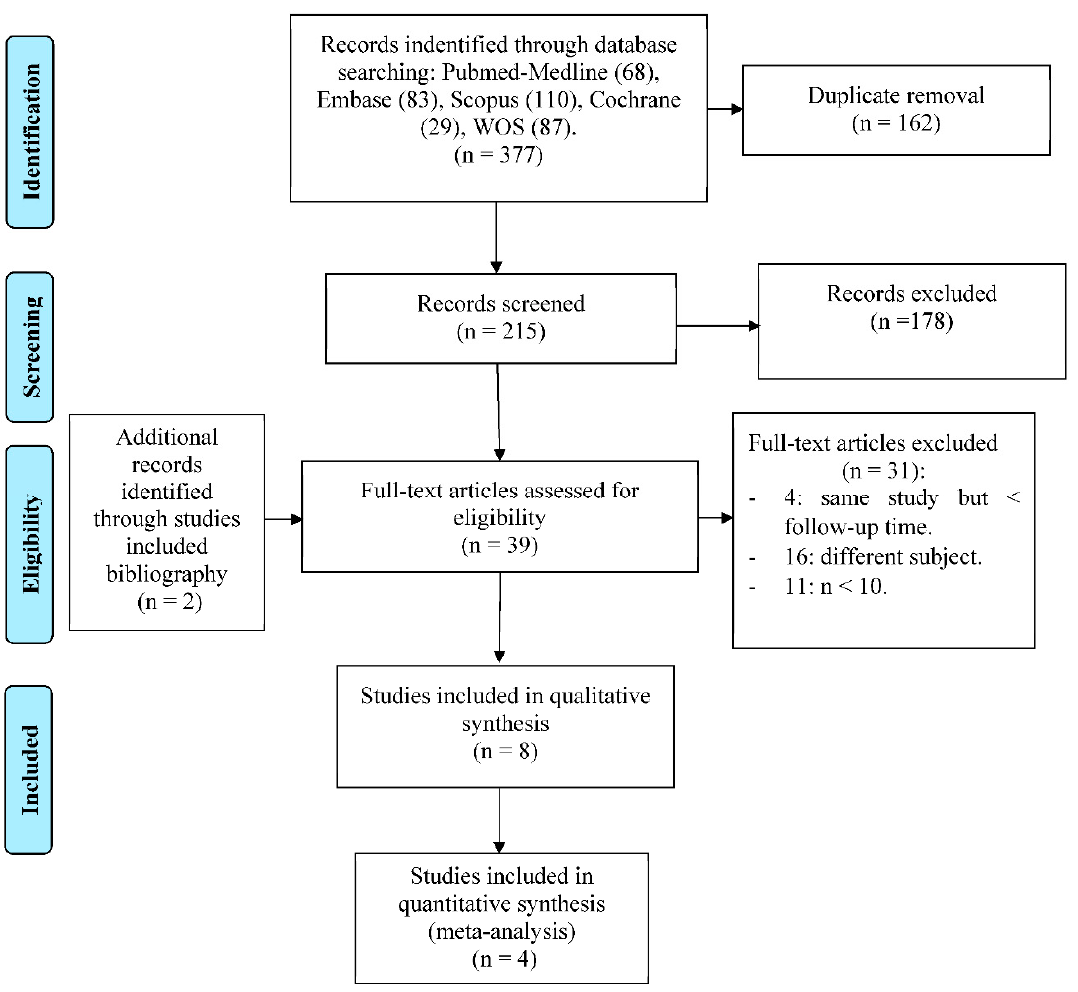
Figure 1. Preferred Reporting Items for Systematic Reviews and Meta-Analyses (PRISMA) Flow diagram.